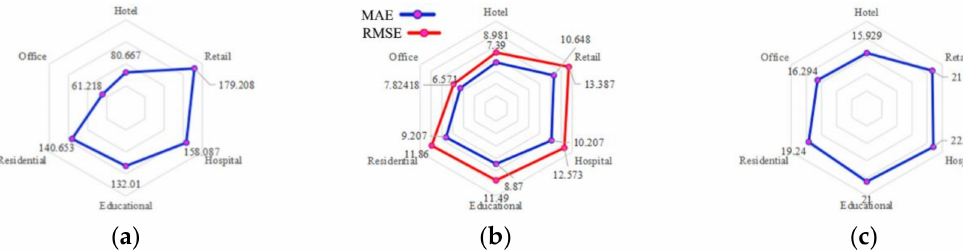
Figure 8. Statistical errors for urban morphology model: ( a ) MSE; ( b ) MAE and RMSE; ( c ) MAPE.